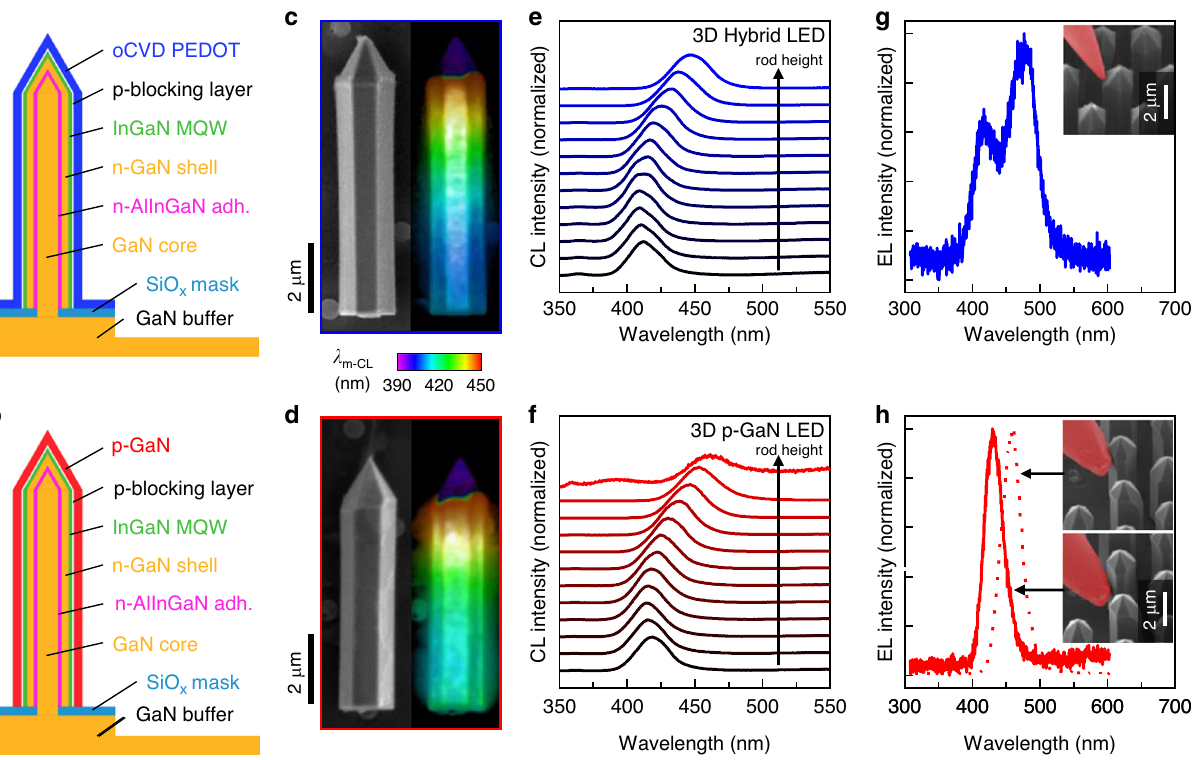
Fig. 5 3D core-shell hybrid (top panels) and p-GaN (bottom panels) LED structures. a , b Sketch of the 3D cross-sectional rod structures. The shell around the n-doped core consists of an InGaN-MQW and is capped with a p-doped AlGaN layer. The p-type contact layer is either a conformal PEDOT or a p-GaN layer. c , d Scanning electron microscopy (left, scale bar: 2 µ m) and hyperspectral cathodoluminescence (CL) maps (right) of individual LED rods indicate a red shift of the InGaN-related luminescence along the rod height which is attributed to a larger concentration of In at the top of the rods. e , f CL spectra at different heights of the rods are obtained by shifting a restricted excitation beam area (about 0.5 × 0.5 µ m 2 ) with a 0.5 µ m step size from the bottom to the top of each rod (indicated by arrows). g , h Electroluminescence (EL) spectra recorded at 200 µ A. Insets show the position of the p-contact needles highlighted in red (scale bar: 2 µ